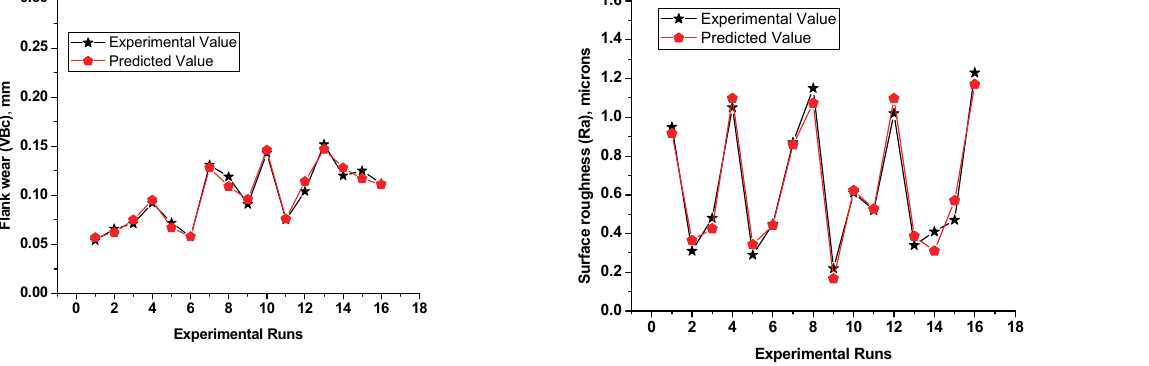
Fig. 4. Experimental vs. predicted values of flank wear